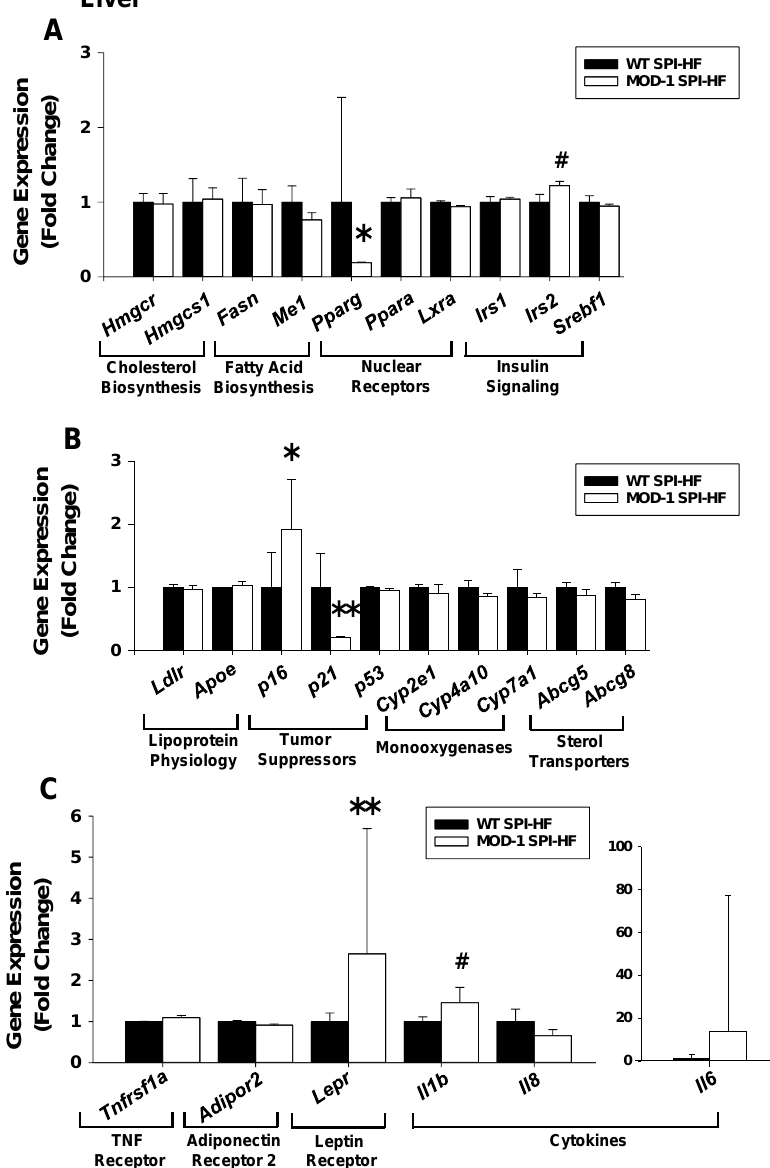
Figure 10. Differential expression of hepatic genes in WT vs. MOD-1 female mice. ( A – C ) qPCR of transcripts encoding select proteins in key pathways. qPCR used Actb and Tbp as normalizers, followed by application of geNorm [25]. Data are mean ± SD for n = 10 WT and n = 11 MOD-1 mice. * p < 0.05, ** p < 0.01, # 0.05 < p < 0.1. Previous work with male MOD-1 mice, as well as transgenic mice over-expressing ME1 in intestines, pointed to the integrative nature of ME1 expressed in the intestines, liver, and adipose tissues [6,26]. Thus, several metabolic (LEPR, TLRs, FFARs) and